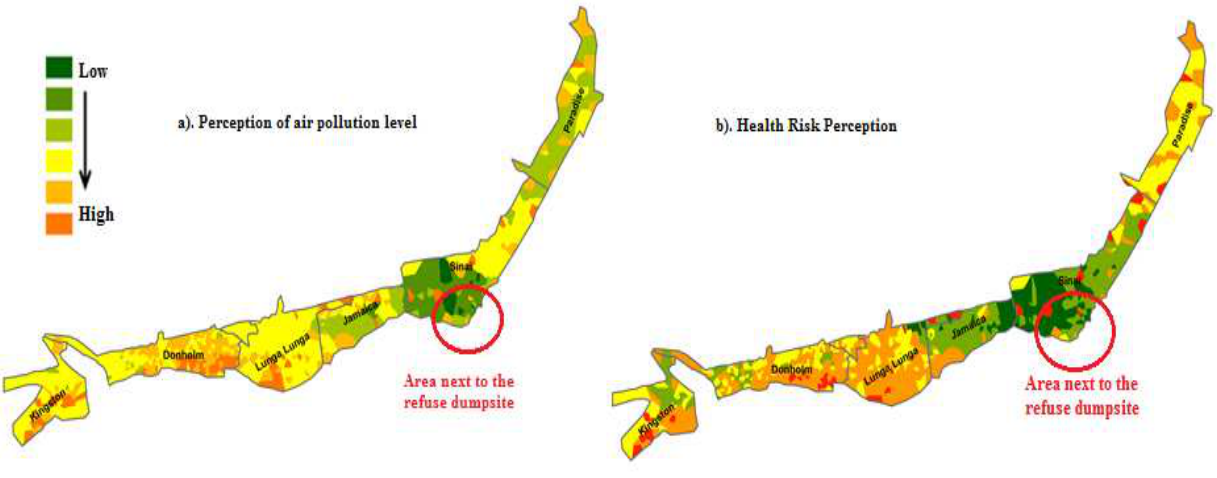
Figure 3. Perceptions on the level of air pollution and related health risks across villages in